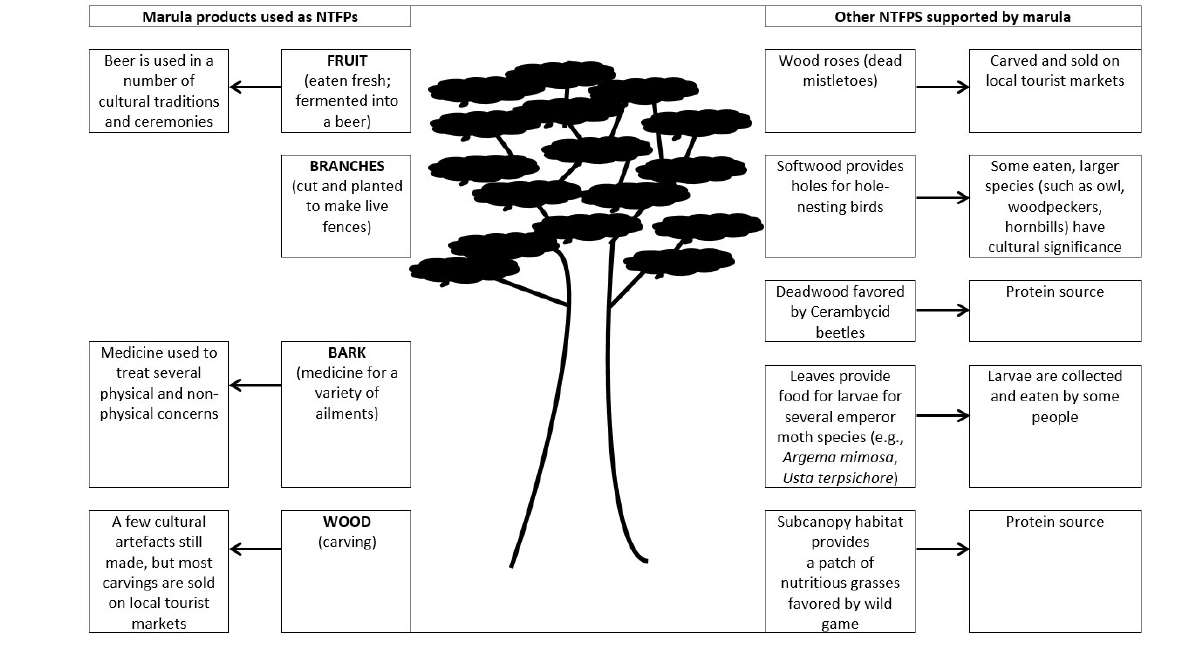
Fig. 3 . Nontimber forest products (NTFPs) harvested directly from marula ( Sclerocarya birrea subsp. caffra ), their cultural significance, and other NTFPs preferentially found in or near marula